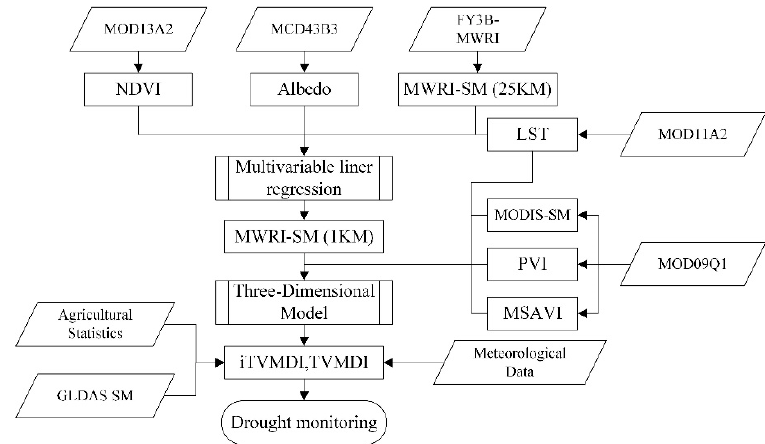
Figure 2. Data processing flow diagram to improve the Temperature–Vegetation–Soil Moisture Dryness Index (TVMDI) based on multi-satellite data.